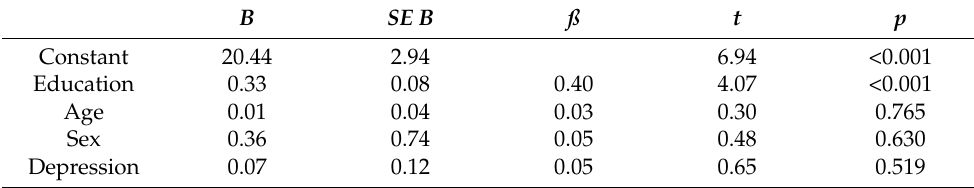
Table 3. Linear regression analysis for Turkish sample on cognition measured with MoCA ( n = 133).